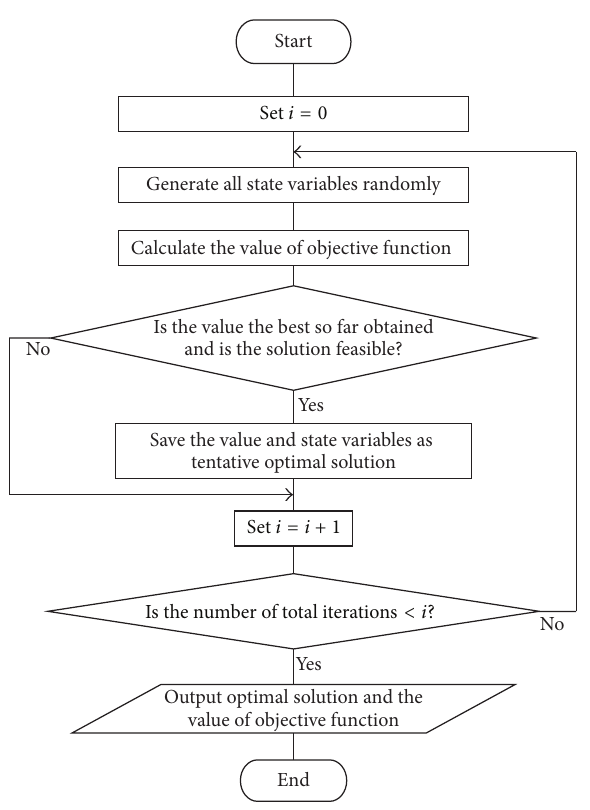
Figure 3: Flowchart of RS